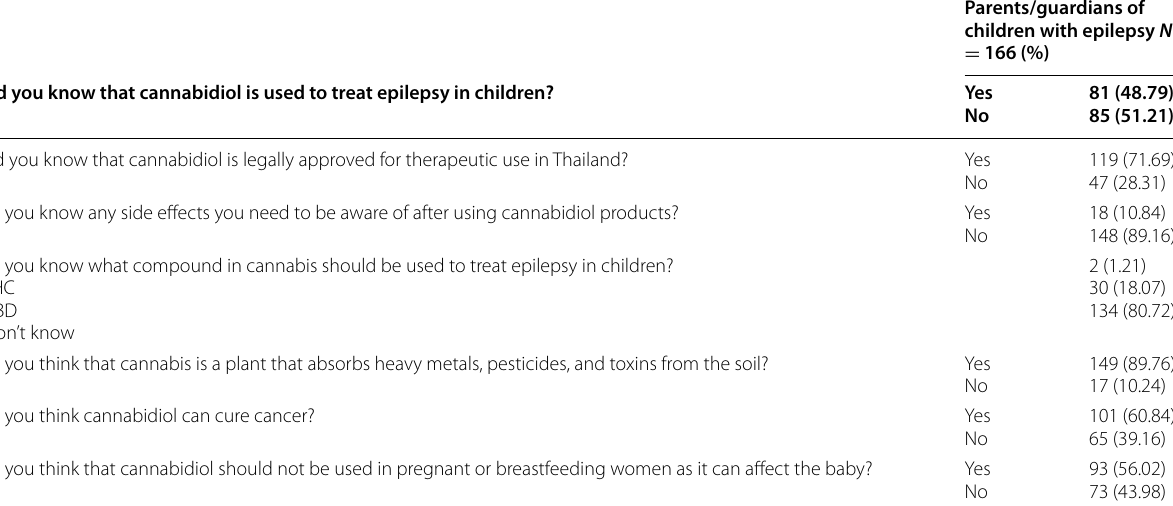
THC tethahydrocannabinol, CBD cannabidiol